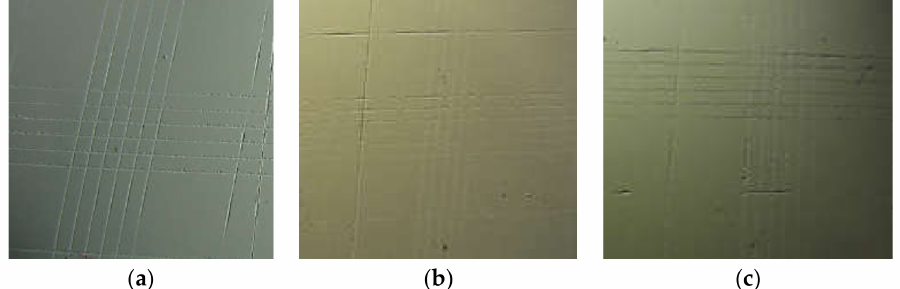
Figure 9. Appearance of the surface affected by the cross-cut area performed after the UV and humidity test, for ( a ) the sample with sand from Ouarzazate, ( b ) the sample with sand from Dubai, and ( c ) the sample without